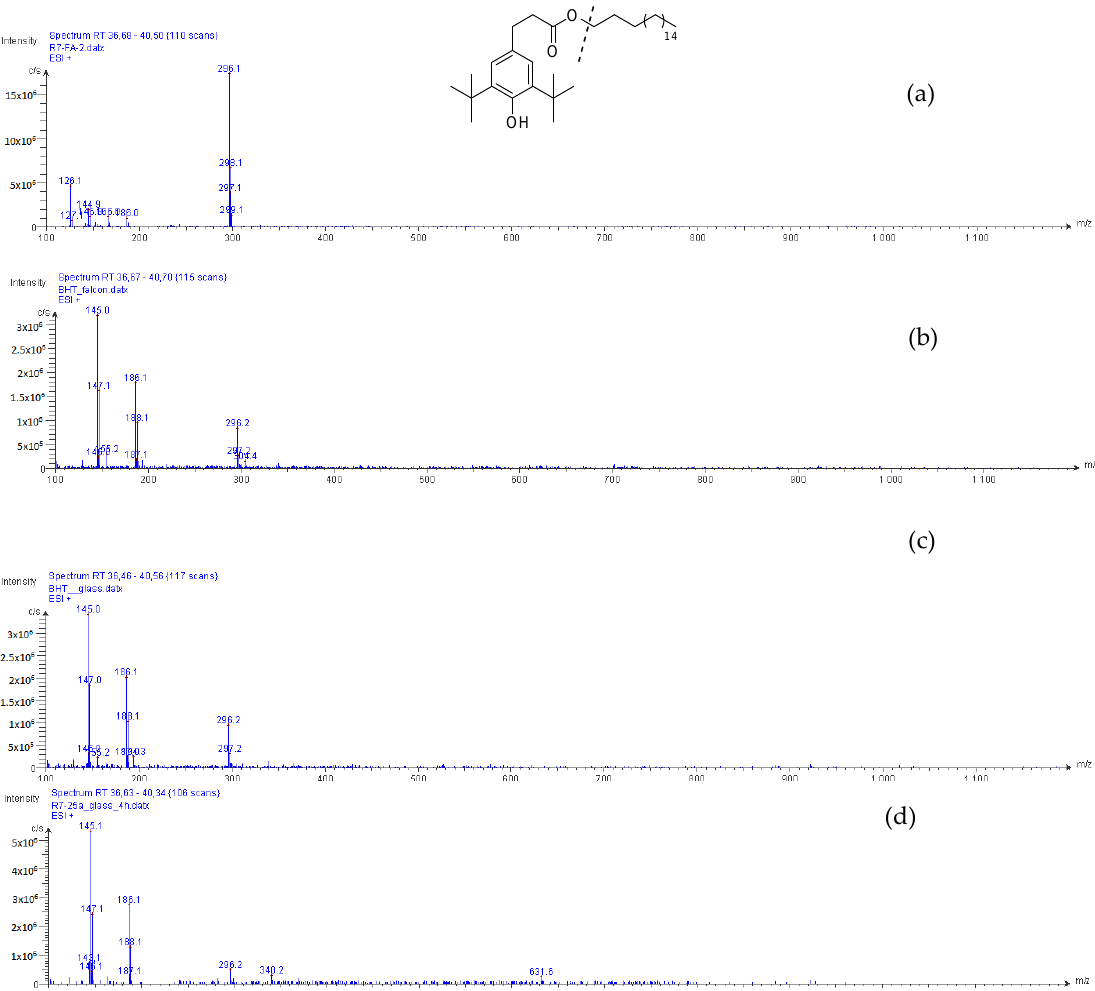
Figure 7. ESI-MS (+) spectra of Compound 2 ( a ), of the extracts from the culture supplemented with BHT in either the culture flask ( b ) or the Erlenmeyer flask ( c ), and of the culture of P. odorifer in the Erlenmeyer flask ( d ).